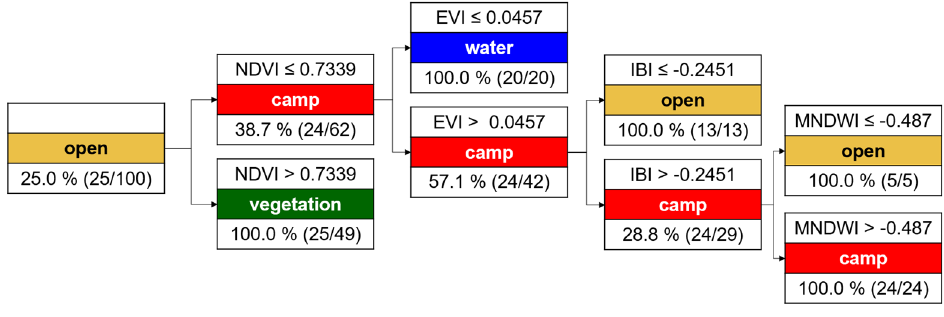
Figure A8. CART for June 2018.